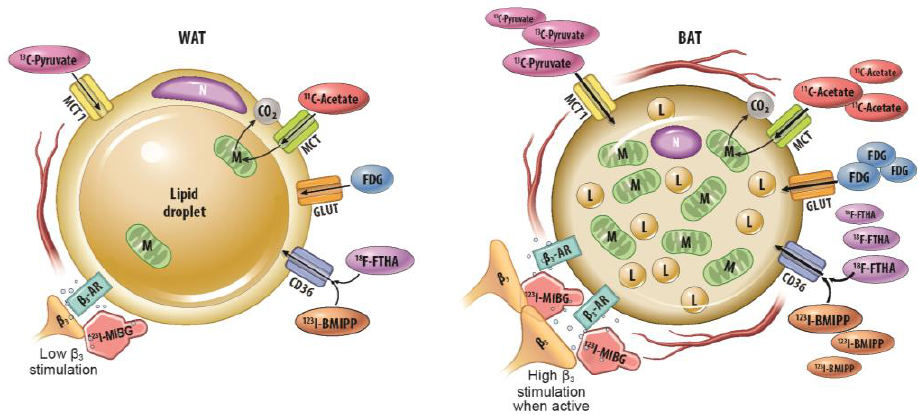
Table 1. Major differences between WAT and BAT on key imaging modalities. Comparison of WAT and BAT on key imaging modalities in BAT research. The relative finding of key factors are listed. ↓ : decreased, ↑ : increased, -: no ionizing radiation, +: ionizing radiation present, ++: more ionizing